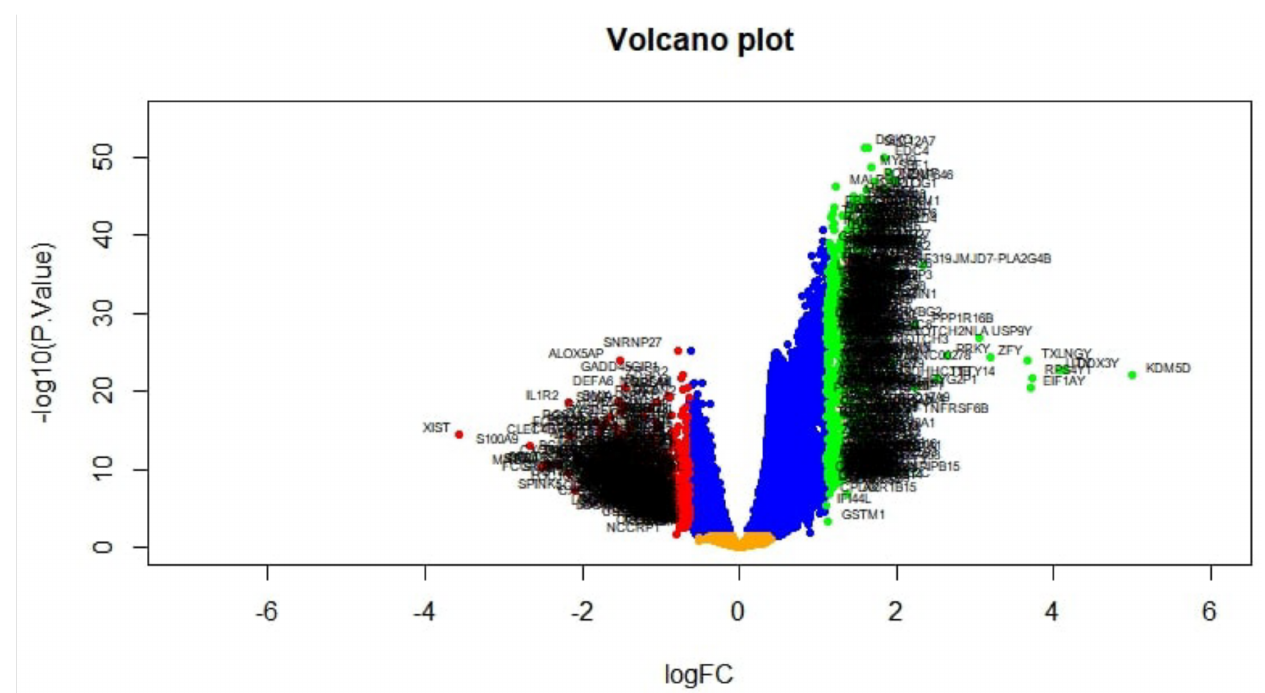
Figure 2. Volcano plot of differentially expressed genes. Genes with a significant change of more than two-fold were selected. Green dot represented up-regulated significant genes and red dot represented down-regulated significant